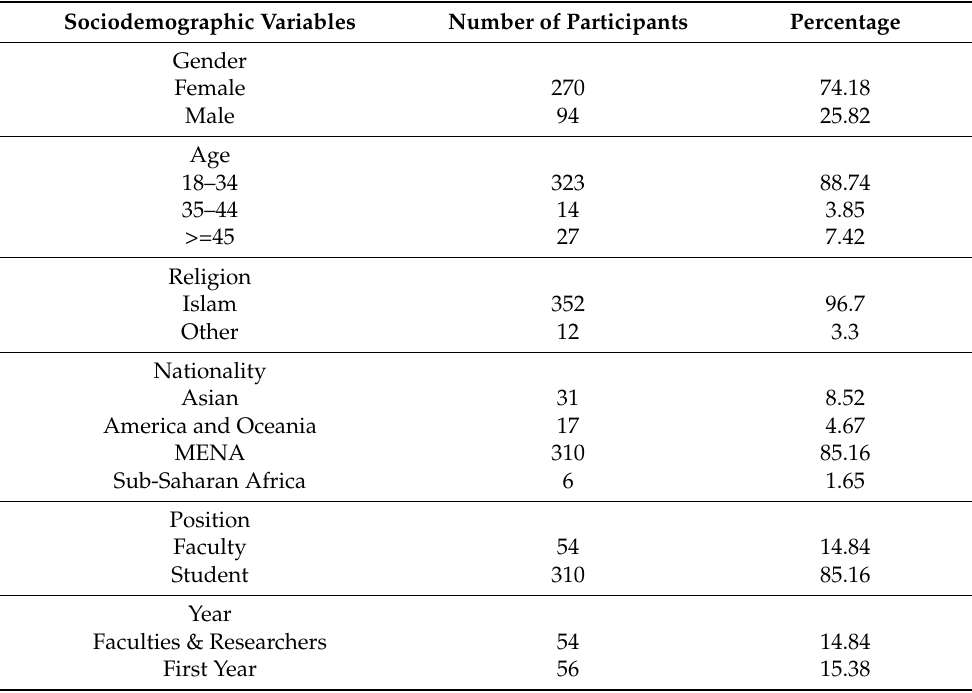
Table 2. Distribution of the sociodemographic data after